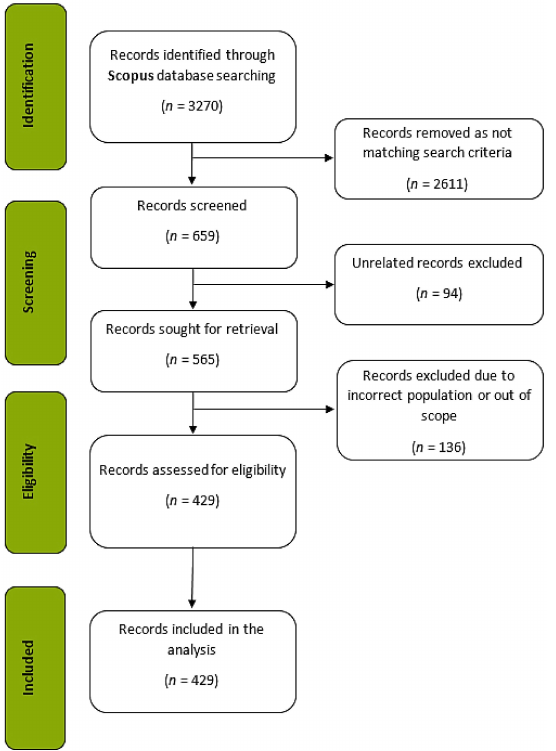
Figure 1. PRISMA flow